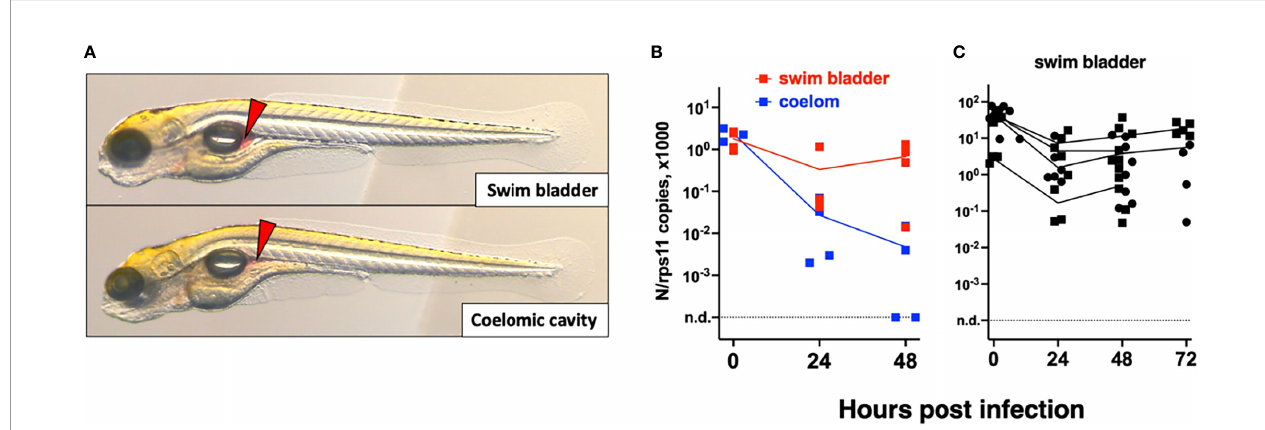
FIGURE 3 | Microinjection of SARS-CoV-2 to 4-dpf larvae. (A) Illustrations of injection in the posterior end of the swim bladder or in the coelomic cavity. (B, C) Quanti fi cation of polyadenylated N transcripts over time, assessed by qRT-PCR; each symbol is an individual larva. (B) Comparison of swim bladder (red) and coelom (blue) injection in a single experiment. (C) Four more swim bladder injection experiments. Lines connect the means of values measured at each time point. Circles and squares correspond to injection of viral suspensions 1 and 2, as labeled on Table 1 .